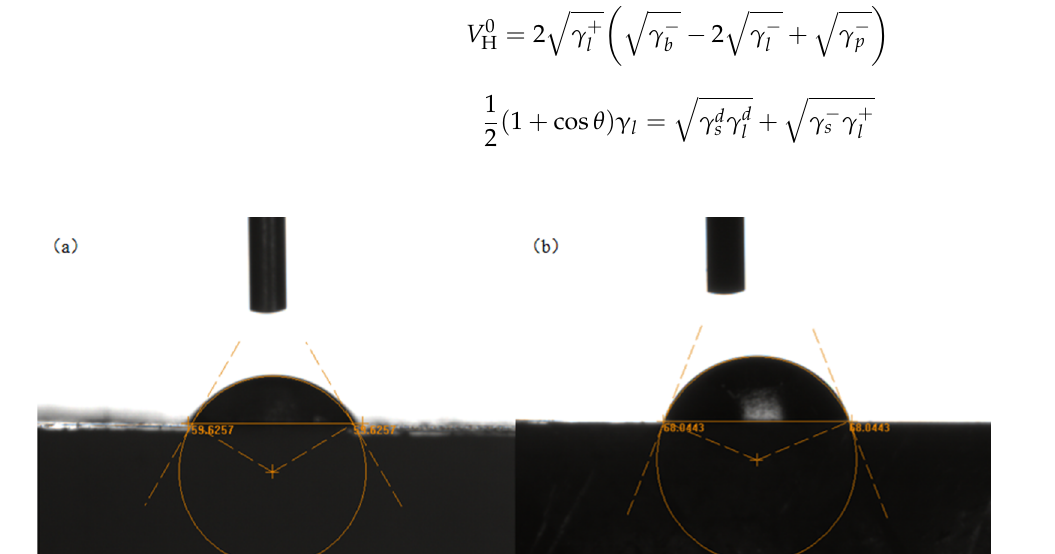
Figure 9. Contact angles of ( a ) fine ilmenite and ( b ) HGB in HGB–NaOL–ilmenite system (NaOL concentration: 4.0 × 10 − 4 mol · L − 1 ).